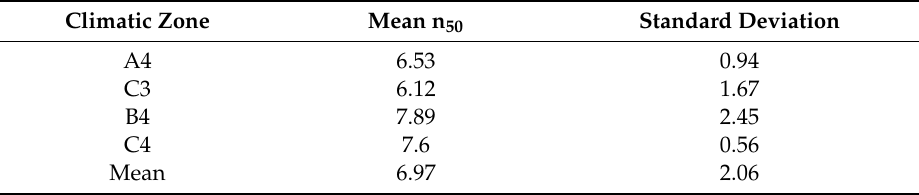
Table 10. Average values and standard deviation of n 50.